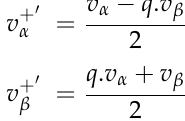
Figure 8. Bloc structure of proposed MSTOGI-MQT1-PLL.